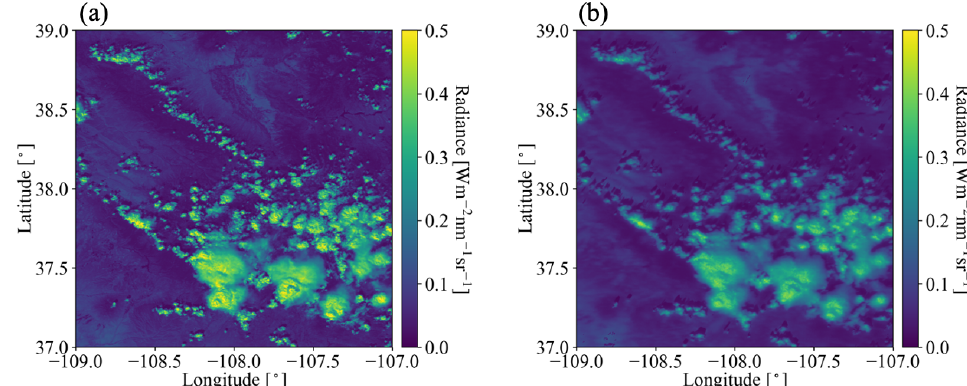
Figure 6. (a) MODIS-measured radiance in channel 1 (650nm). (b) Simulated 3D radiance at 650nm from EaR 3 T. The solar zenith angle for the radiance simulation case is 34.94 ◦ .